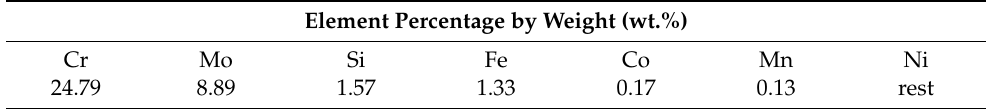
Table 1. Composition of Ni-Cr